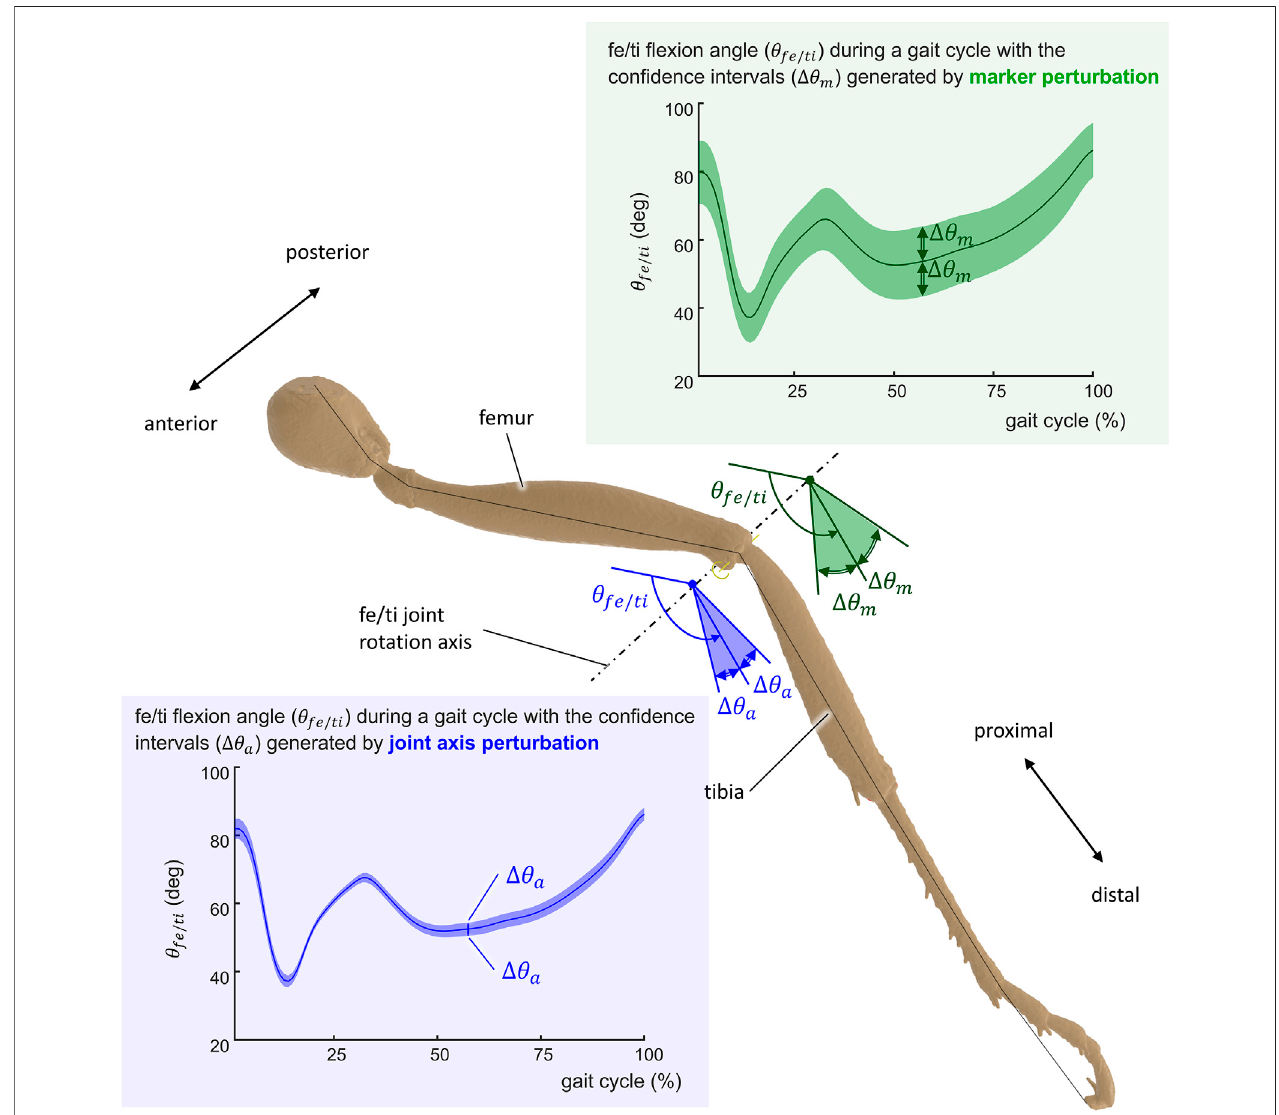
FIGURE 6 | Representation of the uncertainty of the computed kinematics of the ant gait. The uncertainty Δ θ is represented for the femur/tibia angle ( θ fe / ti ) of the middle left leg for joint axis perturbation Δ θ a (blue-shaded con fi dence intervals) and marker position perturbation Δ θ m (green-shaded con fi dence intervals).